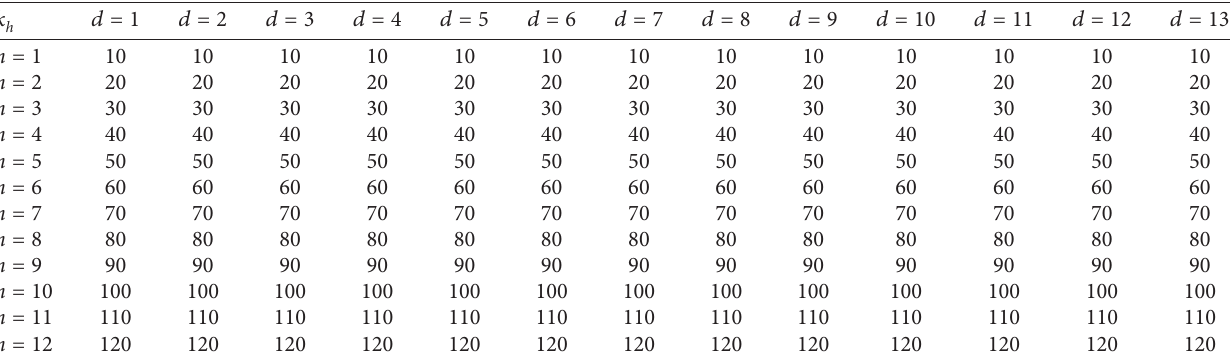
Figure 11: Schematic diagram of element discretization and stiffness modified area. Table 3: The stiffness calculated by equation